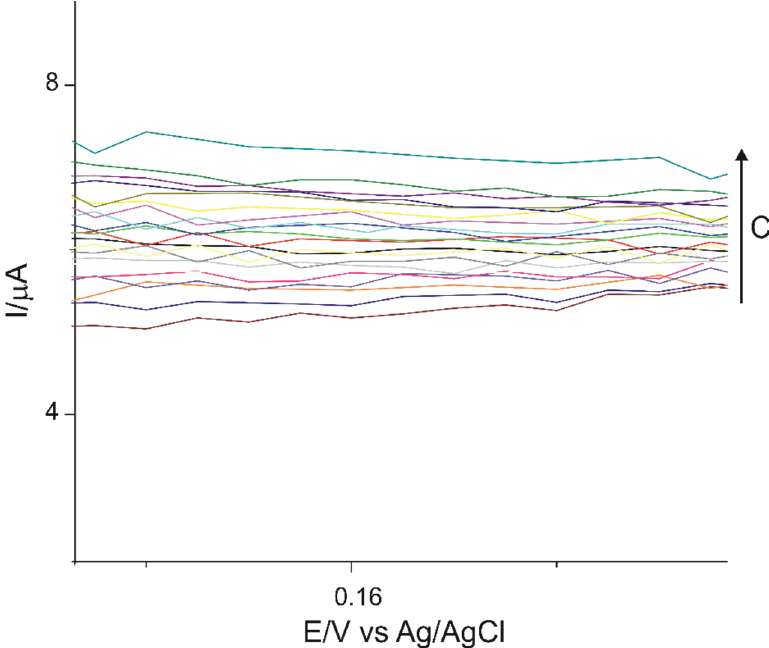
Figure 9. CVs of OMC-SPCE immersed in L-DOPA solution in the concentration range 0.1–1 µM (zoom-in of the anodic peak) .